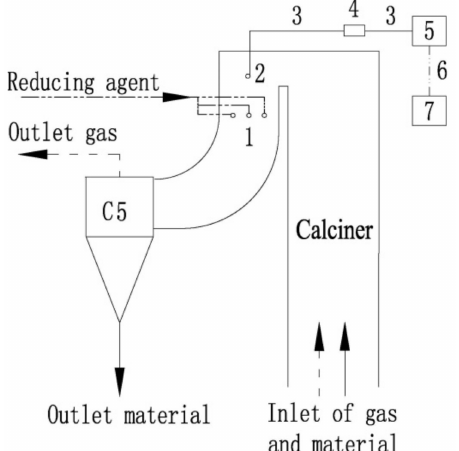
Figure 2. Schematic diagram of NO X background concentration (NBC) acquisition device. 1: reducing agent spray gun; 2: measuring point; 3: gas pipeline; 4: dust filter; 5: portable flue gas analyzer; 6: data transmission line; 7: